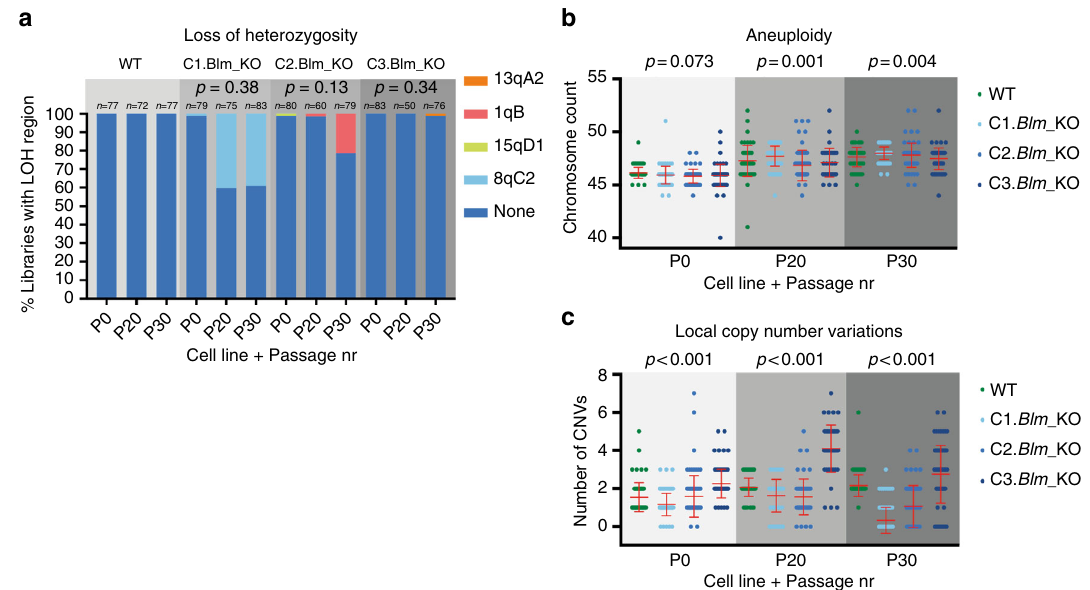
Fig. 5 Low levels of loss of heterozygosity in Blm − / − mouse ES cells. Frequency of a unique LOH regions; b aneuploidy; and c local copy number variations detected at in single-cell whole genome sequencing libraries at different passages in WT, Blm − / − , and Blm +/ − mouse ES cells. The number of single-cell sequencing libraries included in the analysis is shown above each bar. p -values for LOH events were calculated using binomial distributions, for aneuploidy and CNVs by